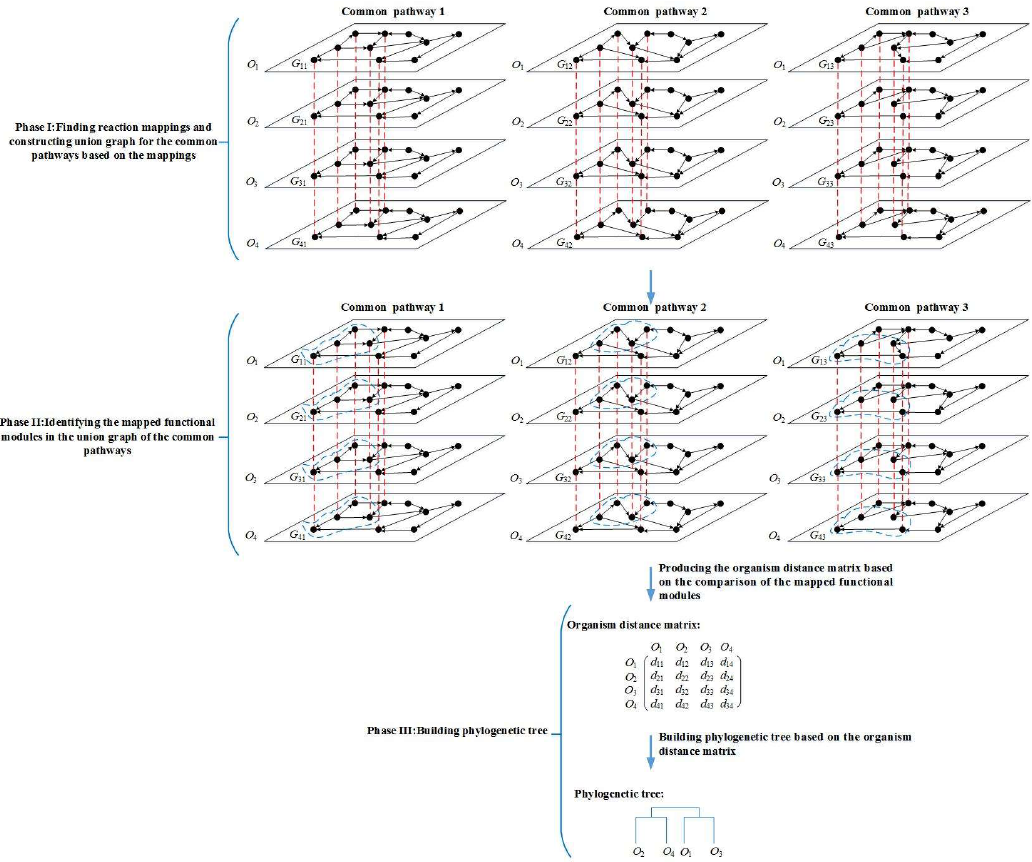
Figure 1. Overview of the MMAL method. MMAL builds the phylogenetic tree for 4 organisms by comparing the common pathways of these organisms in three phases. G ij is the common pathway j of organism O i , i = 1, 2, 3, 4, j = 1, 2, 3. The nodes in the pathways are reactions. The nodes connected with a red dashed line form a reaction mapping between pathways, and each reaction mapping constructs a composite node in the figure. The union graph is a graph that is constructed by the composite nodes and does not have edges. In the figure, each of common pathways 1, 2, and 3 has a union graph. In phase I, the union graph is constructed for common pathways 1, 2, and 3 respectively. In phase II, the mapped functional modules (the modules are composed of the nodes circled in blue dashed line in the figure) in the union graph of common pathways 1, 2, and 3 are identified. In phase III, MMAL obtains organism distance matrix from the comparison of the mapped functional modules, and builds the phylogenetic tree based on the matrix, wherein d ij is the organism distance between organism O i and O j , i = 1, 2, 3, 4, j = 1, 2, 3, 4.